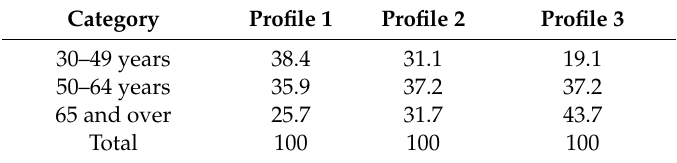
Table 4. Age of ego and relationships according to the three profiles (%).